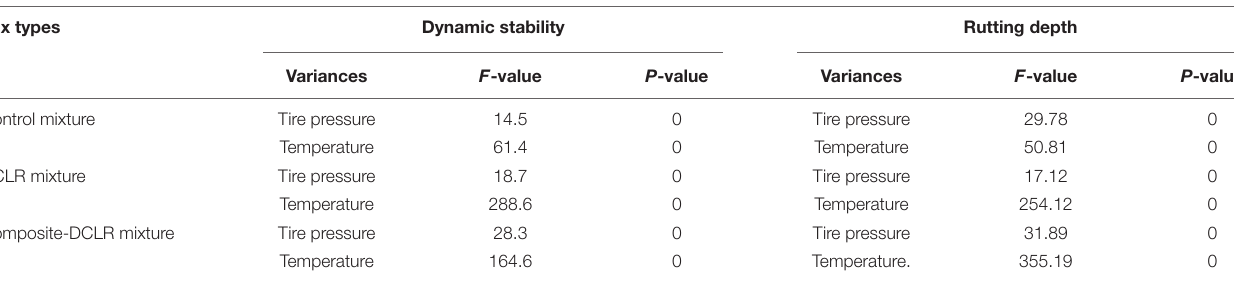
TABLE 4 | Variance of ANOVA of three asphalt mixtures.